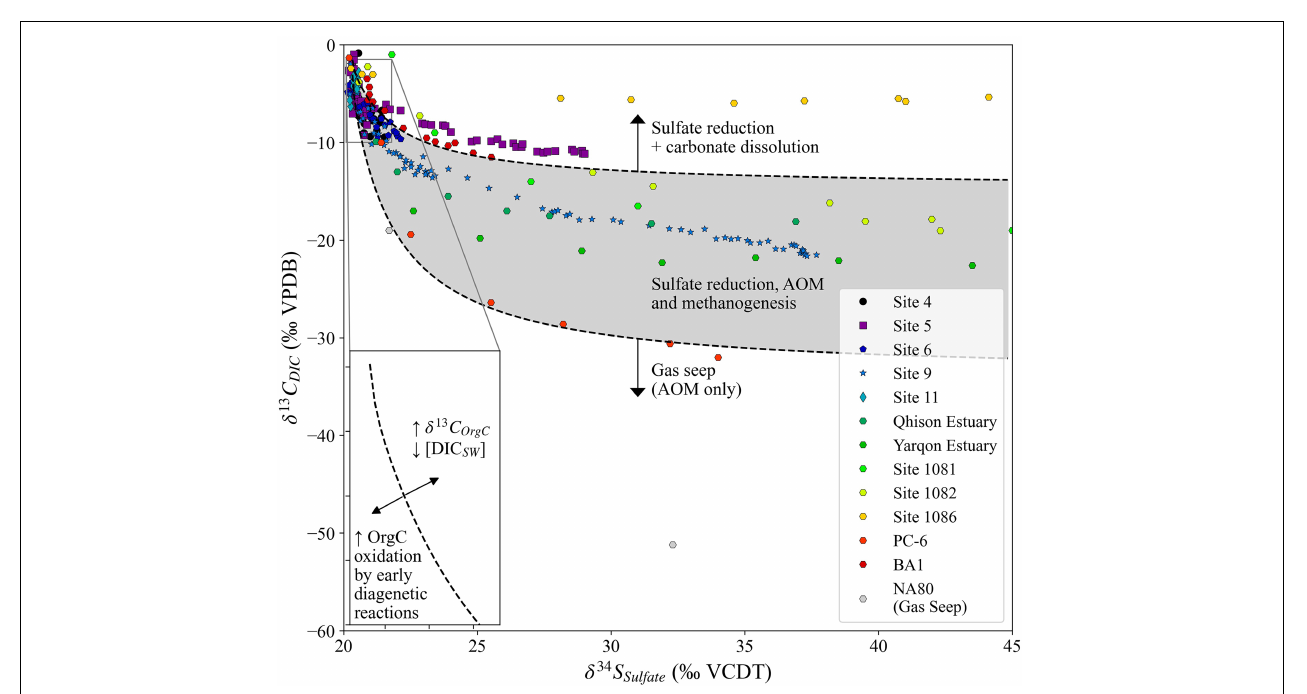
FIGURE 10 | The sulfur and carbon isotopic composition of sulfate and DIC, respectively, for the sites in this paper and a range of literature sites (Sivan et al., 2007; Antler et al., 2013, 2014, 2015; Rubin-Blum et al., 2014). The isotopic compositions of the sites are overlaid by a schematic of the main controls on the sulfur/carbon isotope cross plot and the inset axis contains a schematic for the major controls on the upper left part of the profiles.